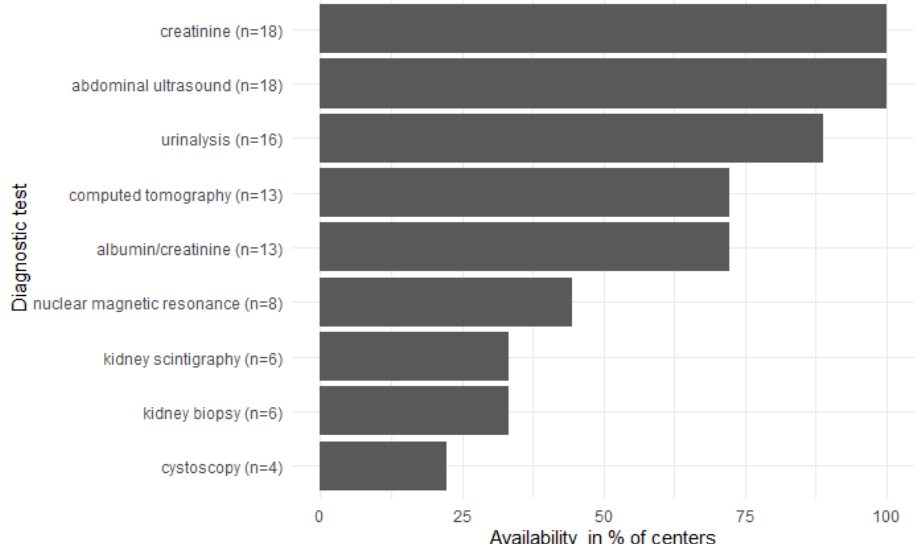
Figure 1. Availability of diagnostic